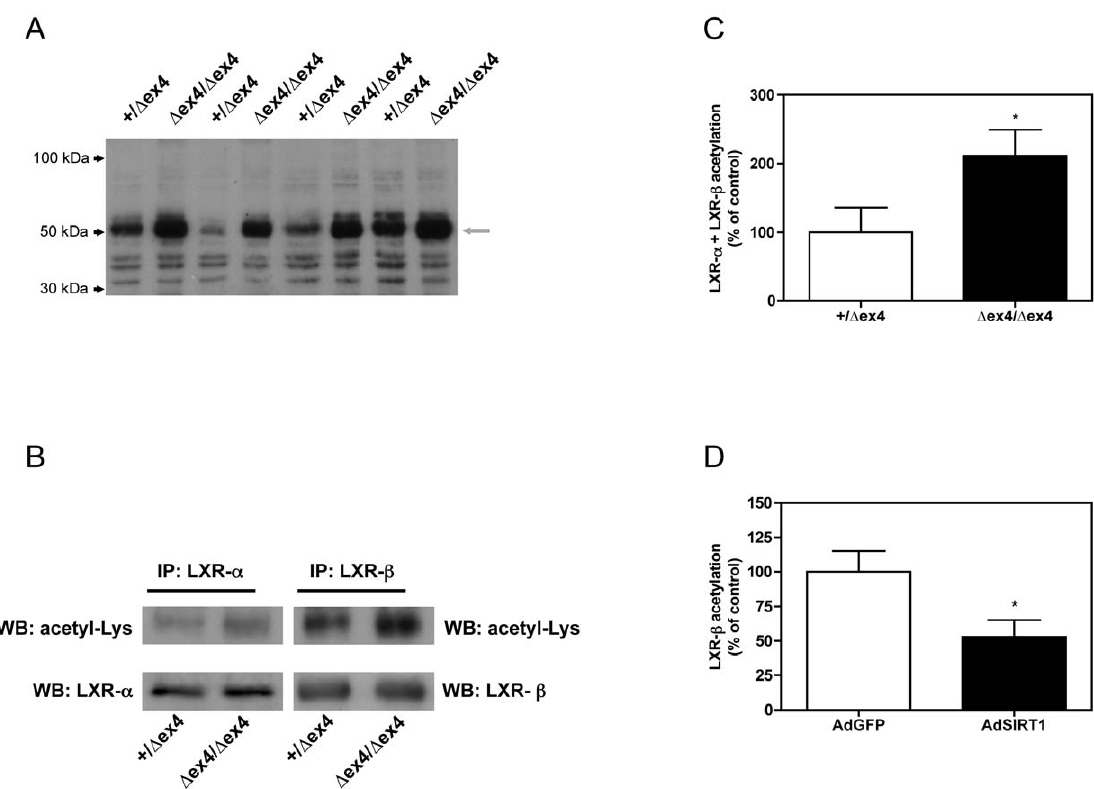
Figure 3. Sirtuin 1 (SIRT1) regulates liver X receptor (LXR)- a and LXR- b acetylation. (A) Immunoblot representing the acetylation profile of gastrocnemius muscle lysates of SIRT1 + / D ex4 and SIRT1 D ex4/ D ex4 mice. Expected LXR band is indicated by a grey arrow. (B) Immunoblots showing LXR- a immunoprecipitates probed either with an acetyl-Lysine antibody (upper left) or a LXR- a antibody (lower left) and LXR- b immunoprecipitates probed either with an acetyl-Lysine antibody (upper right) or a LXR- b antibody (lower right). (C) Acetylation level of LXR- a and LXR- b normalized to the amount of LXR- a and LXR- b in the immunoprecipitate. (D) Acetylation level of LXR- b in human myotubes (7 days of differentiation) infected for 48 hours with recombinant adenovirus expressing either green fluorescent protein (AdGFP) or SIRT1 (AdSIRT1). Proteins were immunoprecipitated with a LXR- b antibody and then probed with an acetyl-lysine antibody. Data were normalized to the amount of LXR- b in the immunoprecipitate. Data are expressed as means 6 SE (n=4/group for animal study; n=8/group for in vitro study). * P , 0.05: significantly different from the